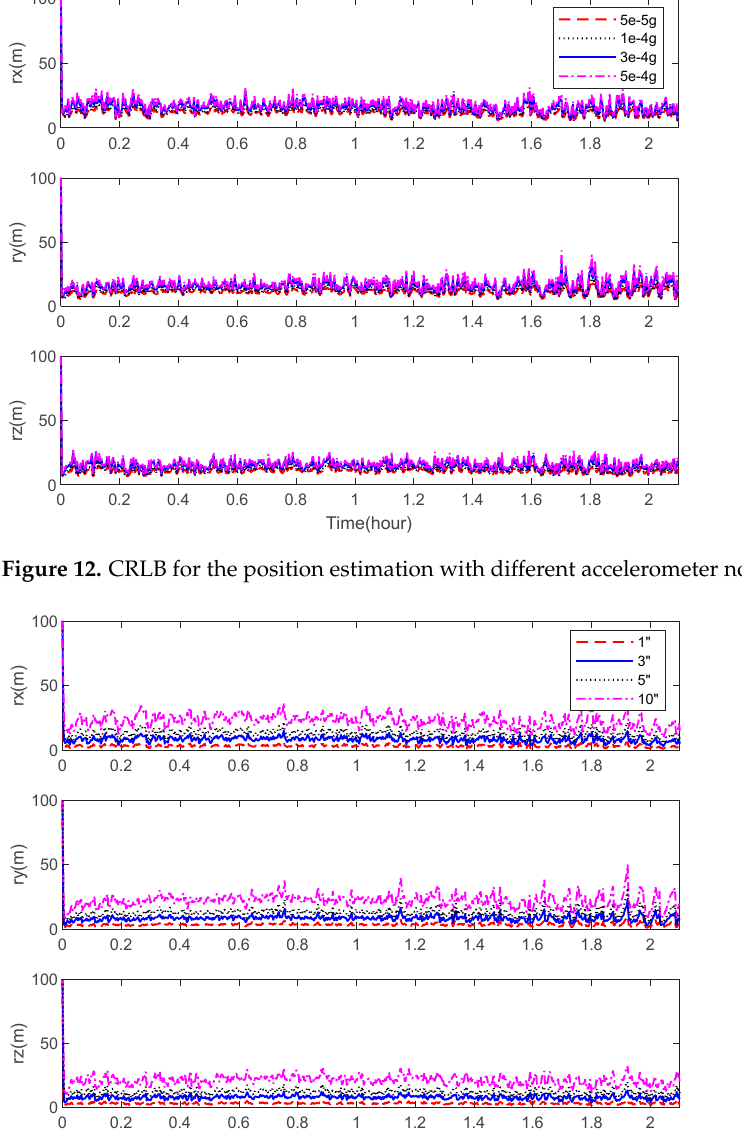
Figure 13. CRLB for the position estimation with different star camera noise levels.